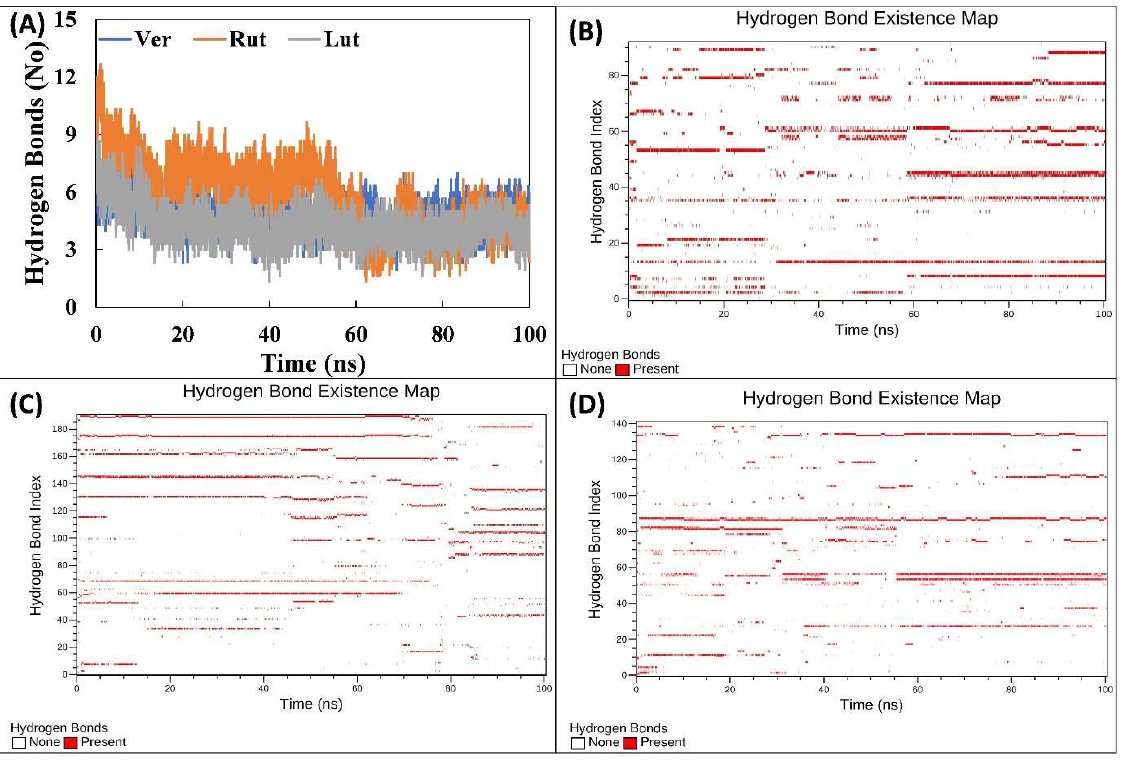
Figure 6. ( A ) Number of hydrogen bonds formed between PKM2-Ver, PKM2-Rut, and PKM2-Lut complexes over the entire course of simulation. The data presented are averages of three independent simulations. ( B ) The hydrogen profile for the interaction of Lut with PKM2. ( C ) The hydrogen profile for the interaction of Rut with PKM2. ( D ) The hydrogen profile for the interaction of Ver with PKM2. Table 6. Binding free energy of ligands with PKM2 calculated by the MM-PBSA method for 100 snapshots of MD simulation.